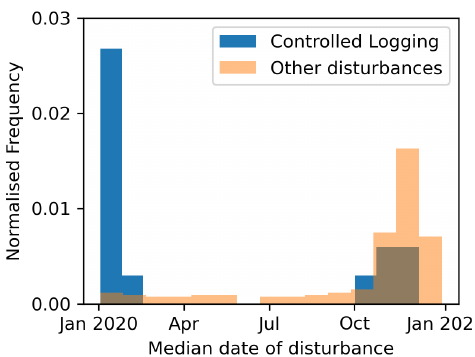
Figure 7. Median date of Sentinel-1 detected shadows intersecting canopy gaps caused by a con- trolled selective logging experiment in late January (blue) and those caused by later logging of the surrounding area (orange). The histograms are normalised, and are in agreement with Rougier Gabon records, indicating the area was disturbed in November and